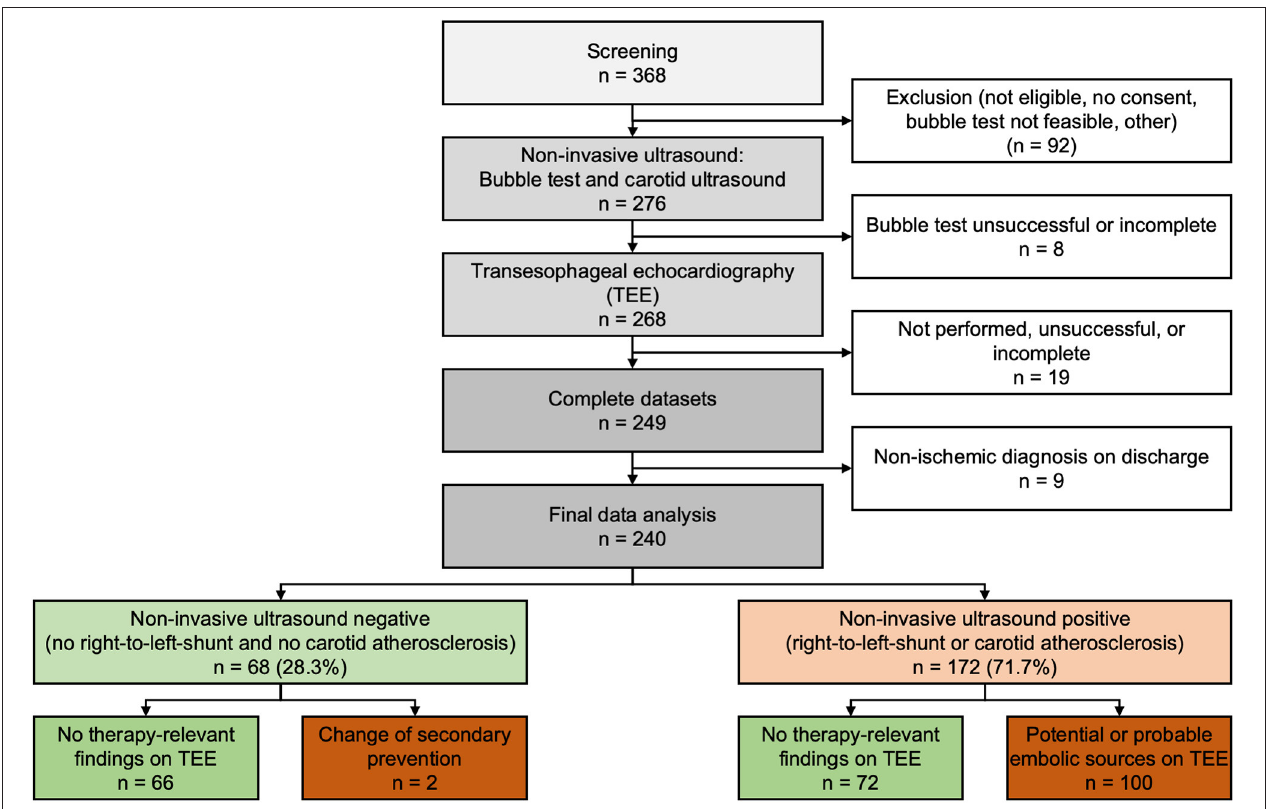
FIGURE 2 | Recruitment and diagnostic results of patients in the study cohort.